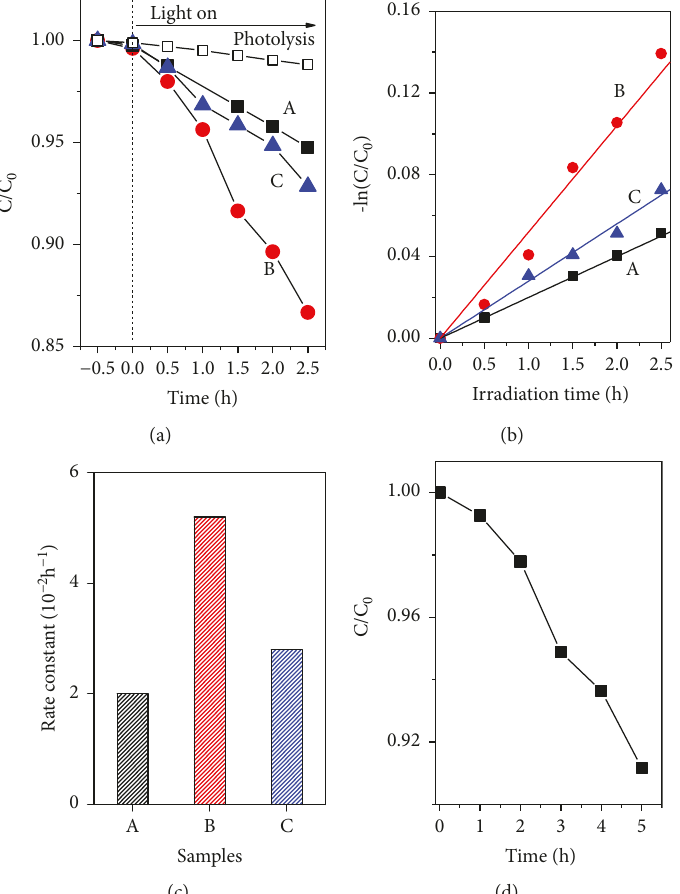
Figure 5: (a) RhB concentration varied with reaction time, (b) plot of − ln( C / C dichlorid phenol concentration varied with reaction time over sample